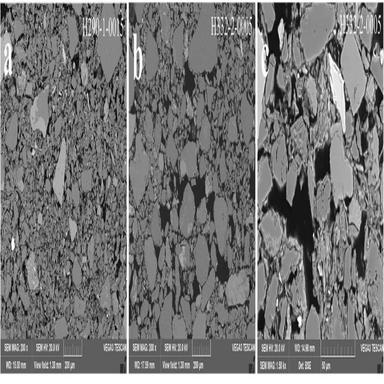
The BSE micrographs of the mould samples with Texture B.